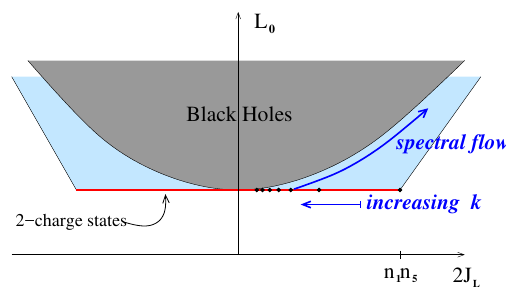
Figure 3. Two-charge supertubes occupy the (red) BPS line in the spectrum of states with left- moving energy L 0 and angular momentum J L . Spectral (cid:13)ow of these states moves them parallel to the cosmic censorship bound where the BTZ black hole entropy formula (1.2)